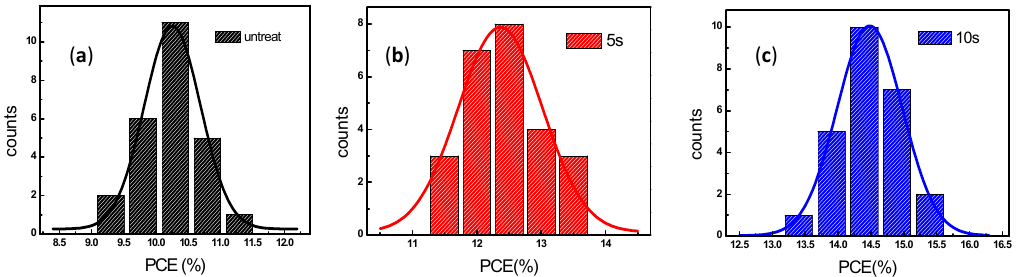
Figure A4. Histograms of PCEs measured for 25 cells that MA gas treating with different times. Processing time: ( a ) 0 s, ( b ) 5 s, ( c ) 10 s.